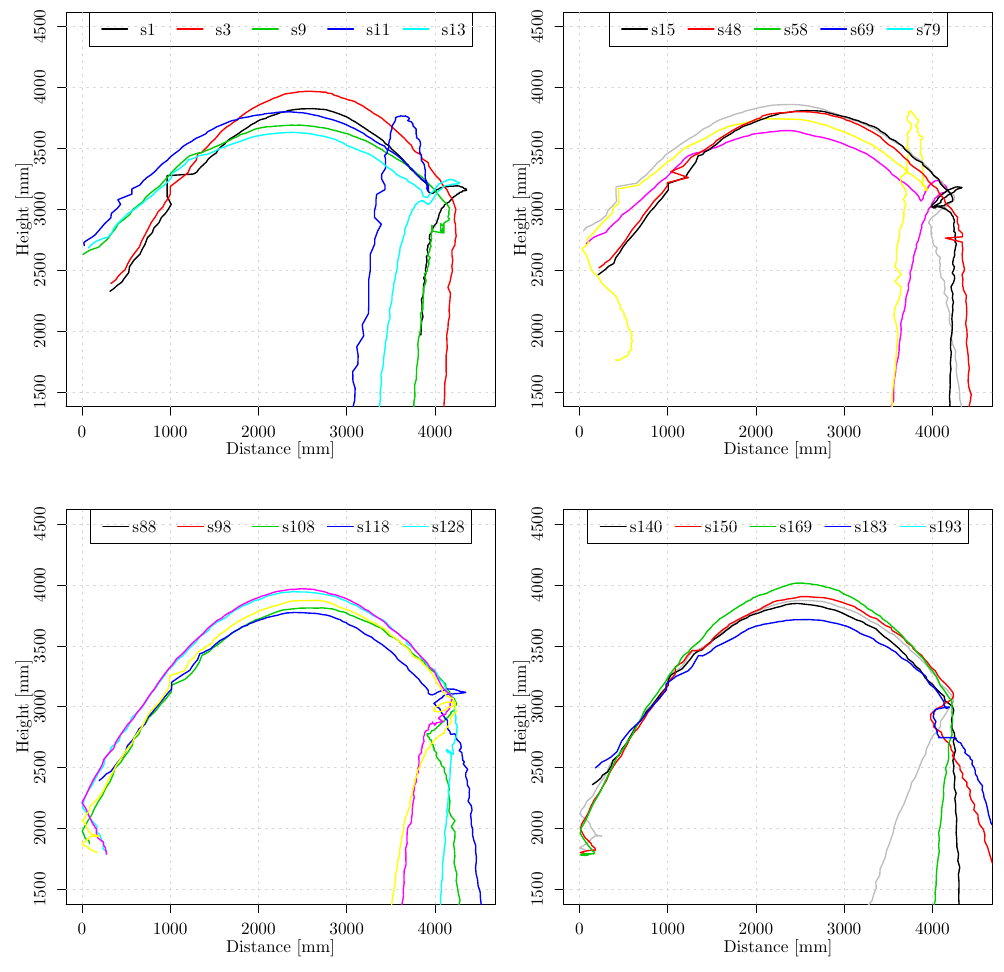
Figure 7. Ball trajectory for selected